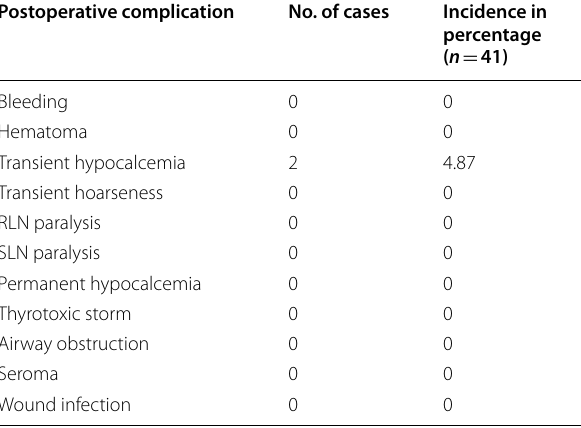
Table 2 Incidence of postoperative complications Postoperative